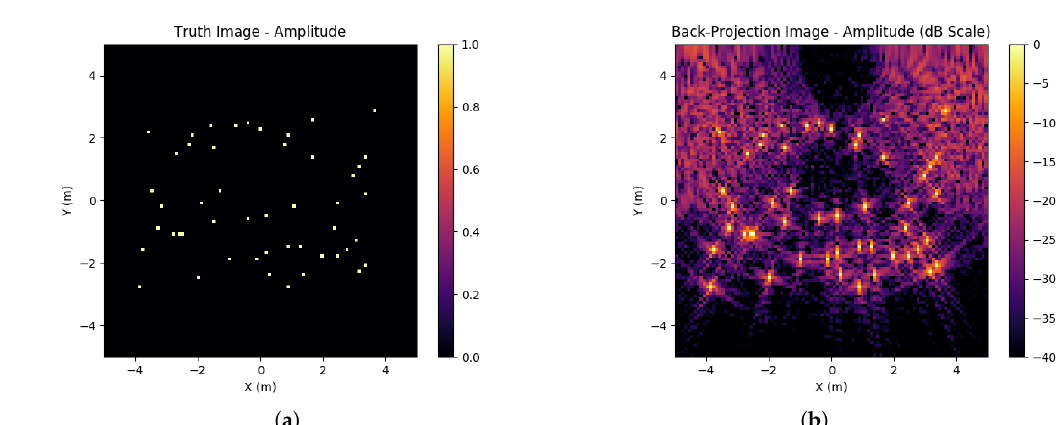
Figure 9. Ground truth and corresponding back-projection for 50 randomly-placed scatterers. ( a ) Ground truth of 50 randomly placed scatterers; ( b ) Image formed via back-projection for full aperture and no noise.